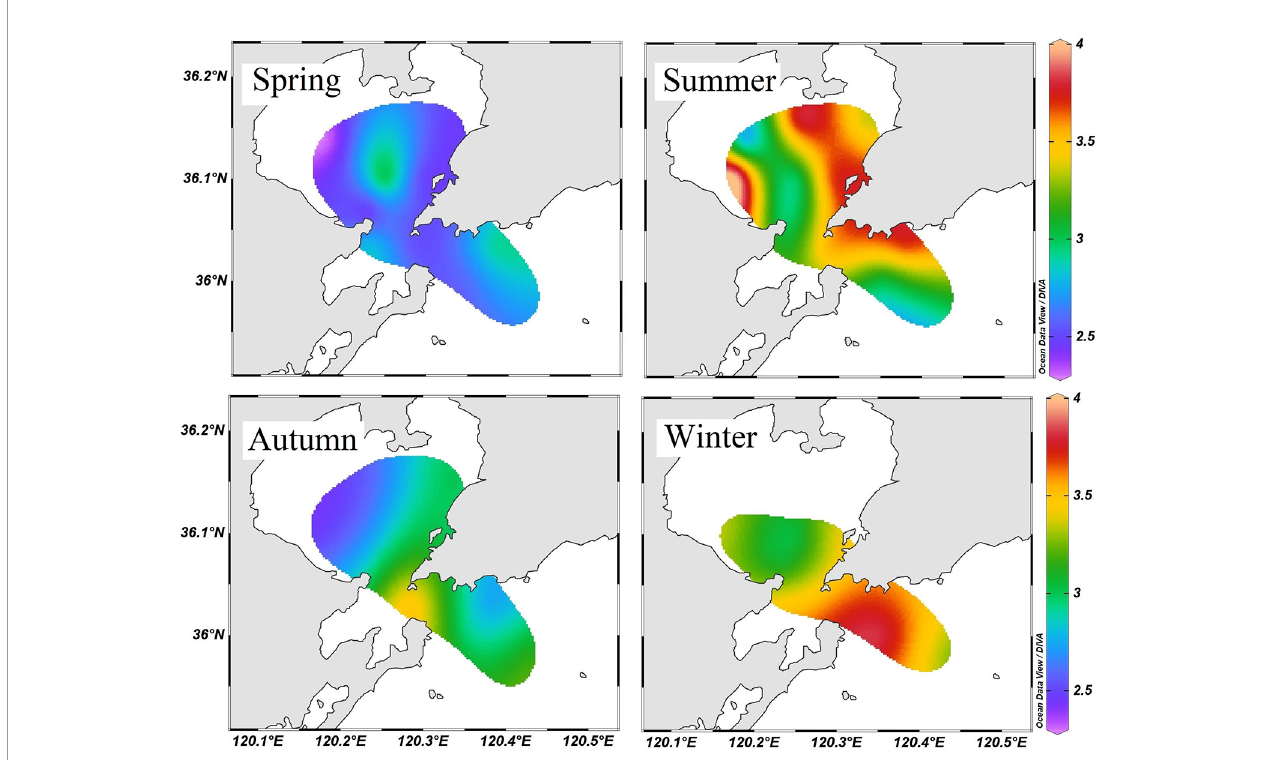
FIGURE 6 | Relative trophic level of Sagitta spp. calculated using small zooplankton (<500 m m) as the baseline (trophic level = 2).